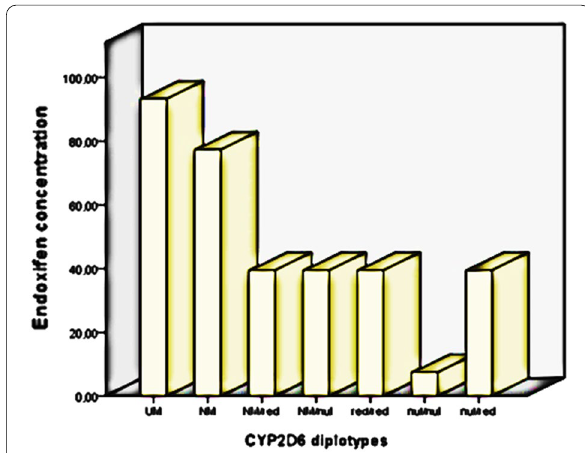
Fig. 4 Plasma Endoxifen concentrations in women with estrogen receptor-positive breast cancer in relation to major groups of CYP3A5